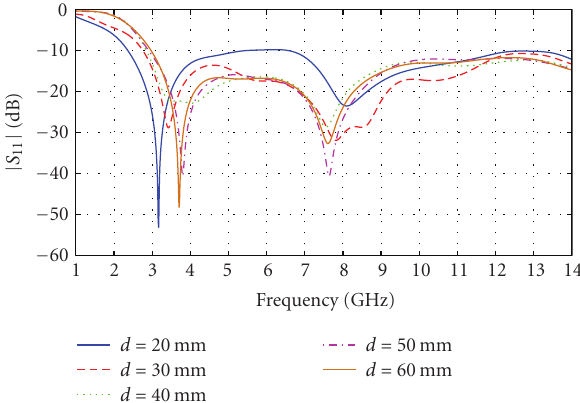
Figure 14: Simulated | S 11 | results of four-element UWB